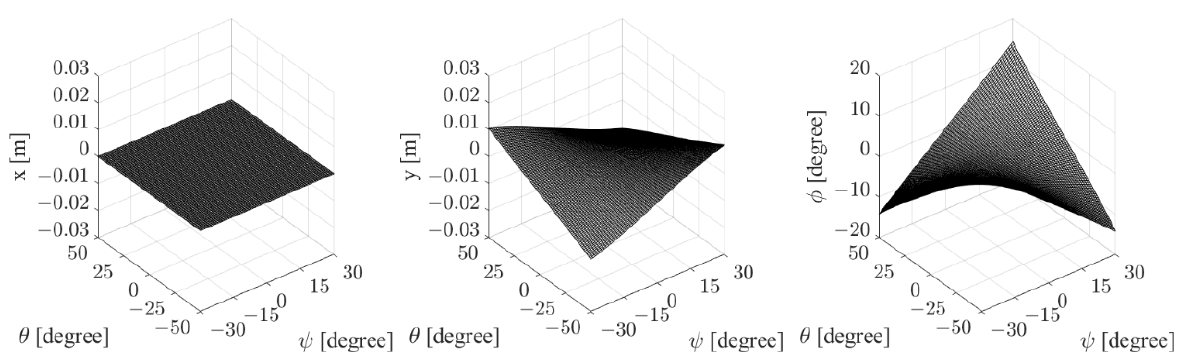
Figure 6. Parasitic motion of the 3-RPS robot.